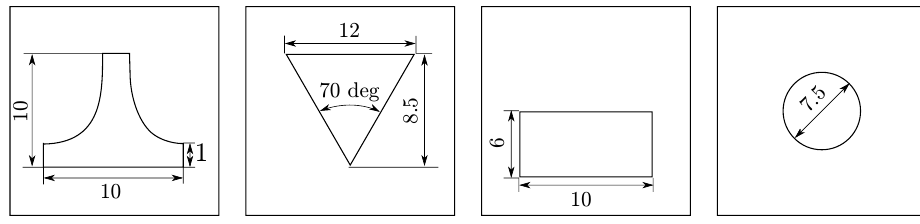
Figure 4. Sharp crested weirs (dimensions in cm): linear, v-notch, rectangular and circular.